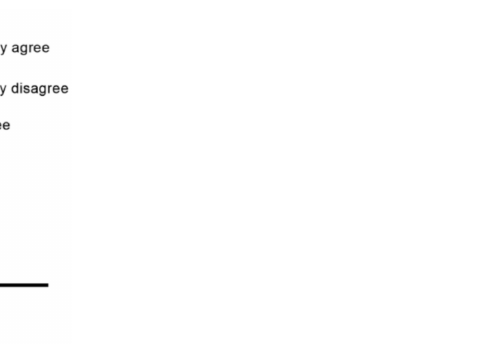
Figure 3. Responses to the statements: “When using the LA dental simulator, I felt engaged in a learning activity”, and “I think the use of LA dental simulator would be helpful in teaching LA administration